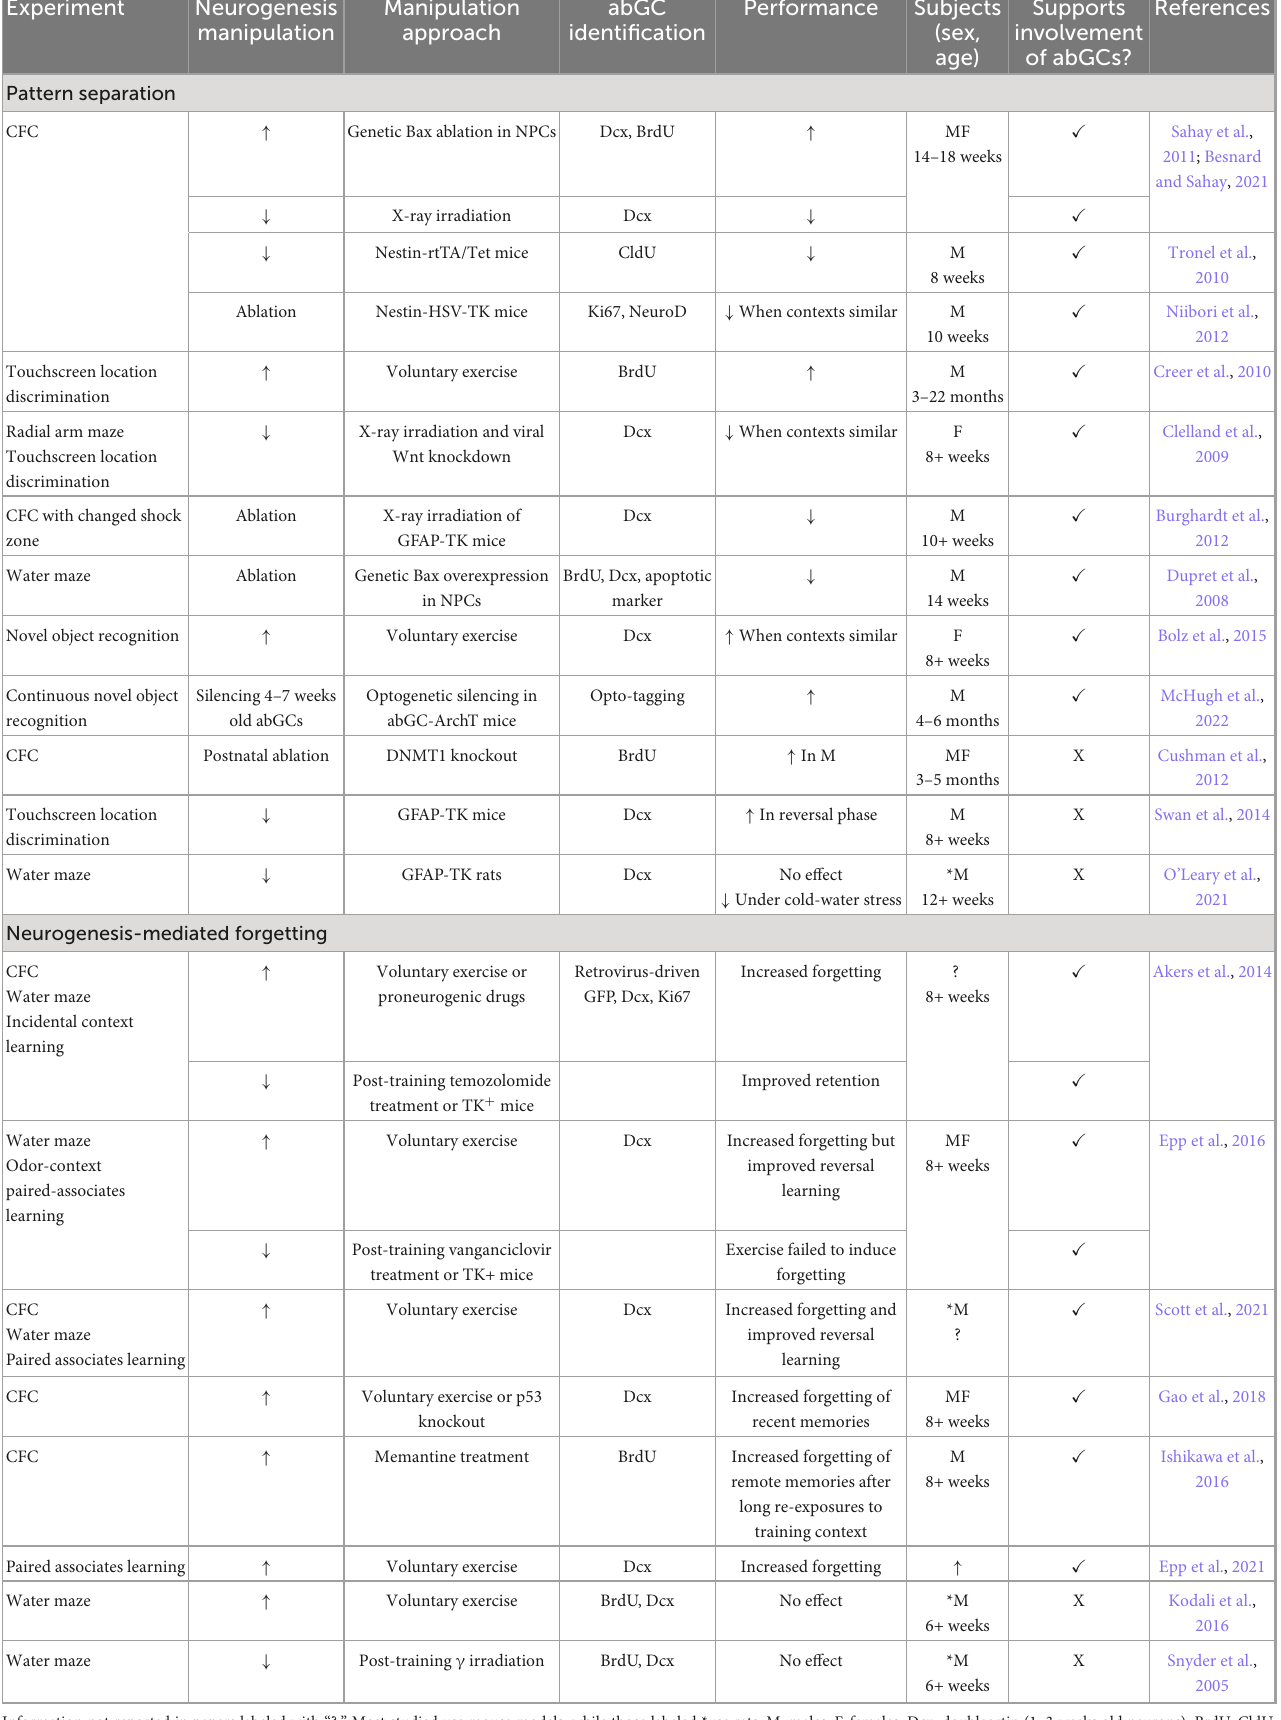
TABLE 1 Key studies on the effect of hippocampal neurogenesis on behavioral pattern separation and